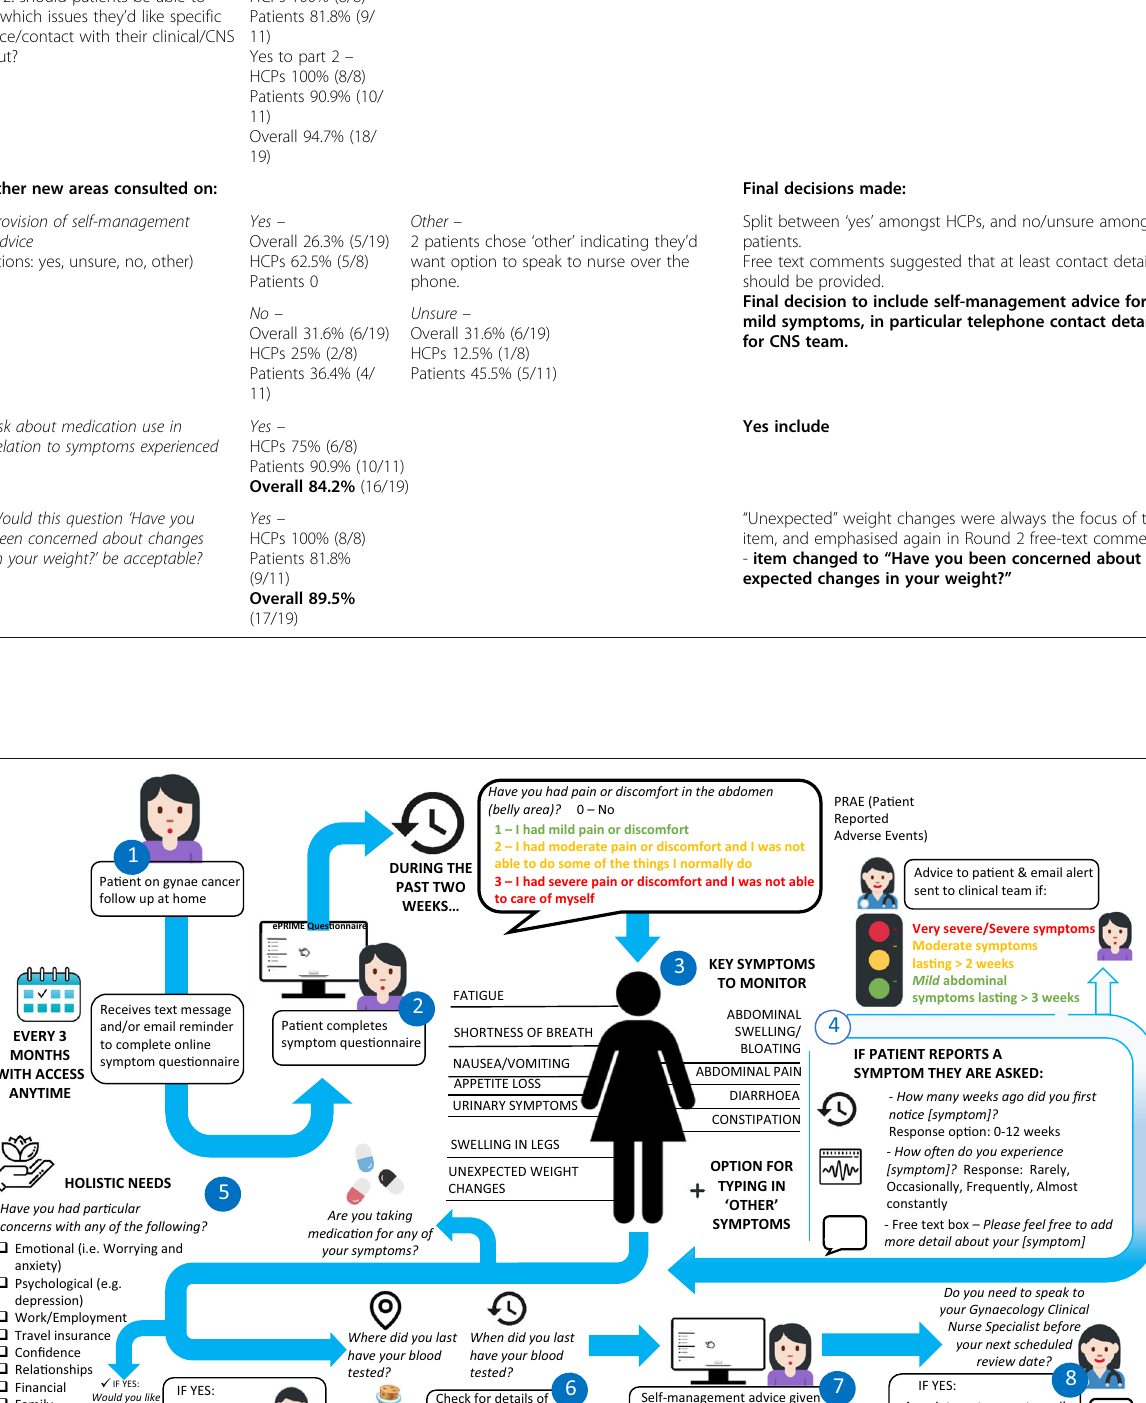
Table 2 Results from each round, percentage of agreement for each area and the consequent decisions made (Continued) List of non-physical holistic needs Part 1: “ Would a page like this be acceptable to you? ” and Part 2: should patients be able to